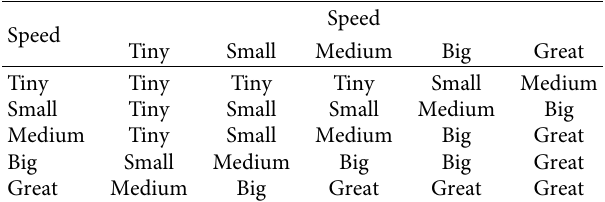
i . Table 3: Fuzzy inference rules.